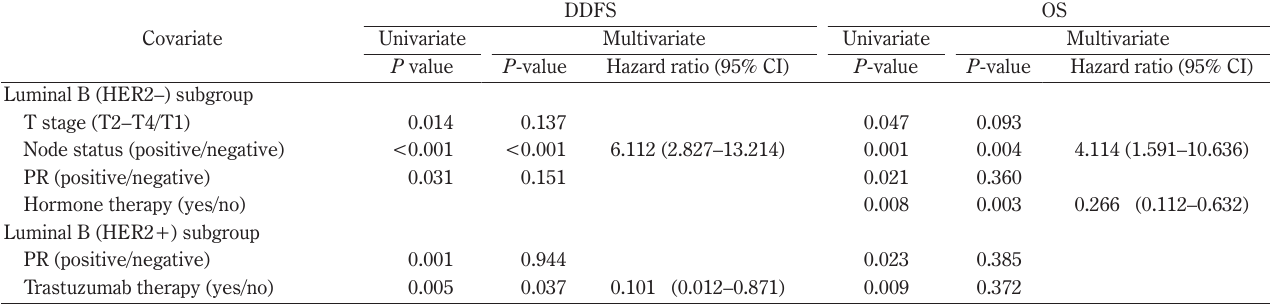
Table 4 Multivariate Cox analysis of DDFS and